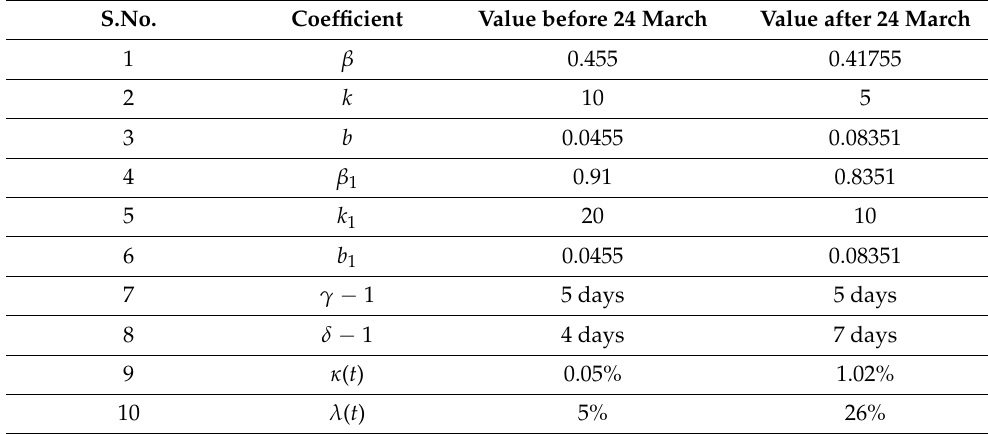
Table 4. Fitted parameters of the proposed SEIHRD model before and after 24 March.